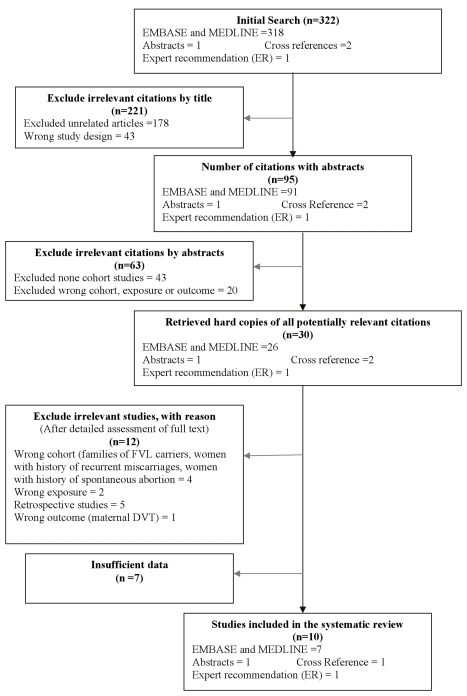
Study selection.